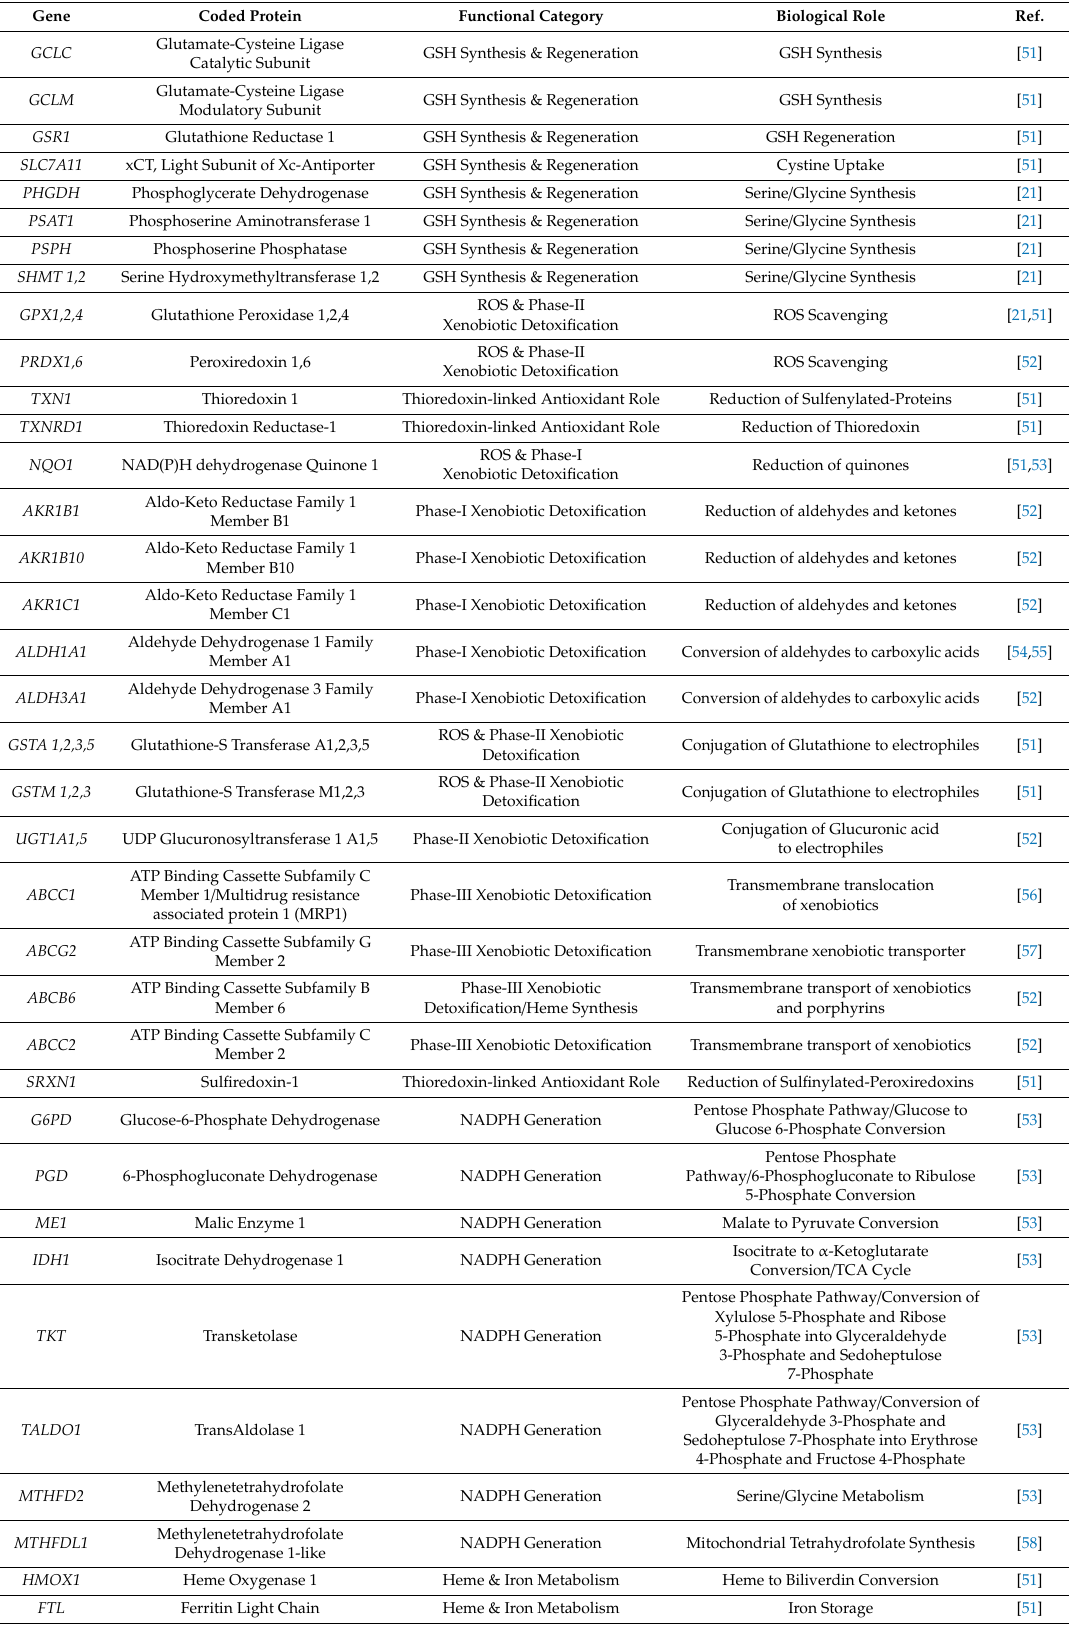
Table 1. Selected list of NRF2 target